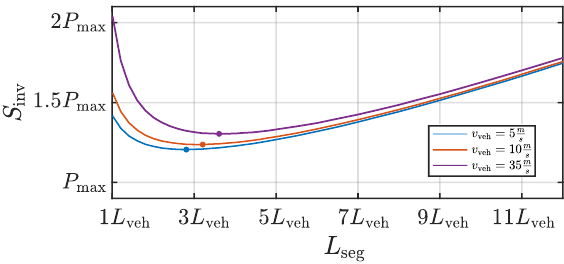
Figure 6. Inverter power in relation to L seg for various v veh